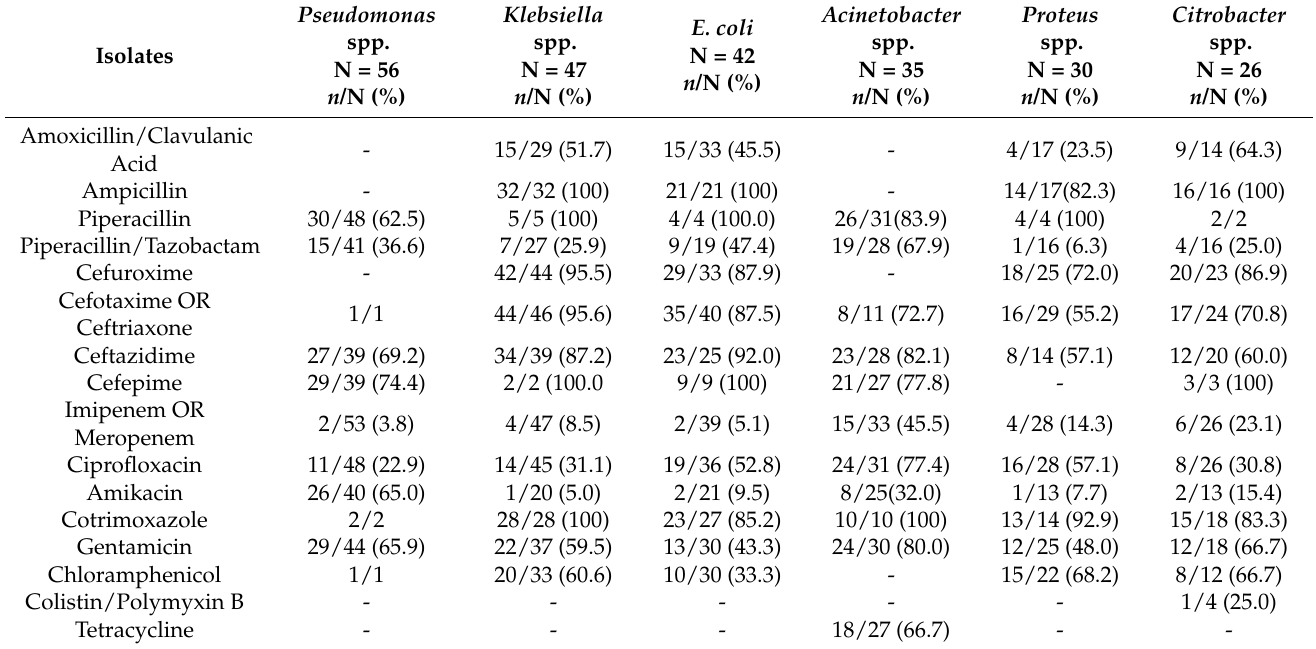
Table legend: 1 Pathogens identified in wound